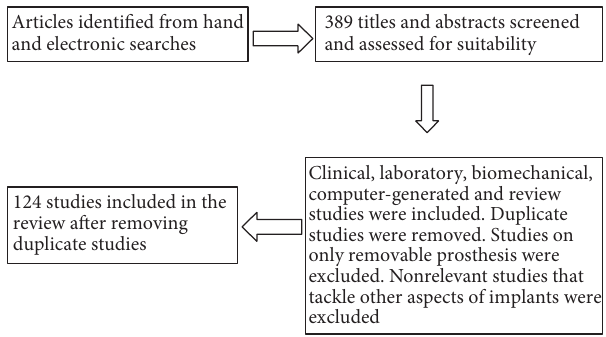
Figure 1: Diagram showing the process of selection of papers for this